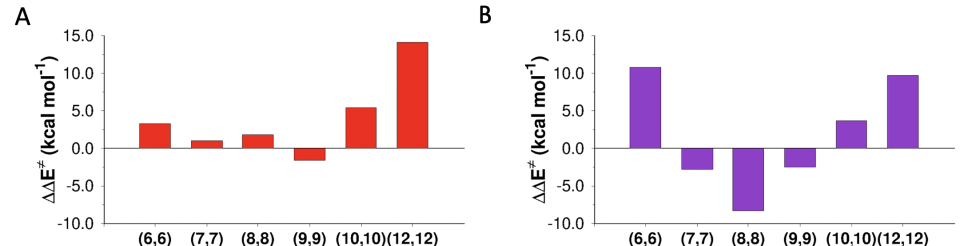
Figure 5. Activation energy variations with respect to the gas phase ( ∆ E ‡ ) of the ( A ) anti -E2 and ( B ) the syn -E2 reactions inside CNTs of different diameters.